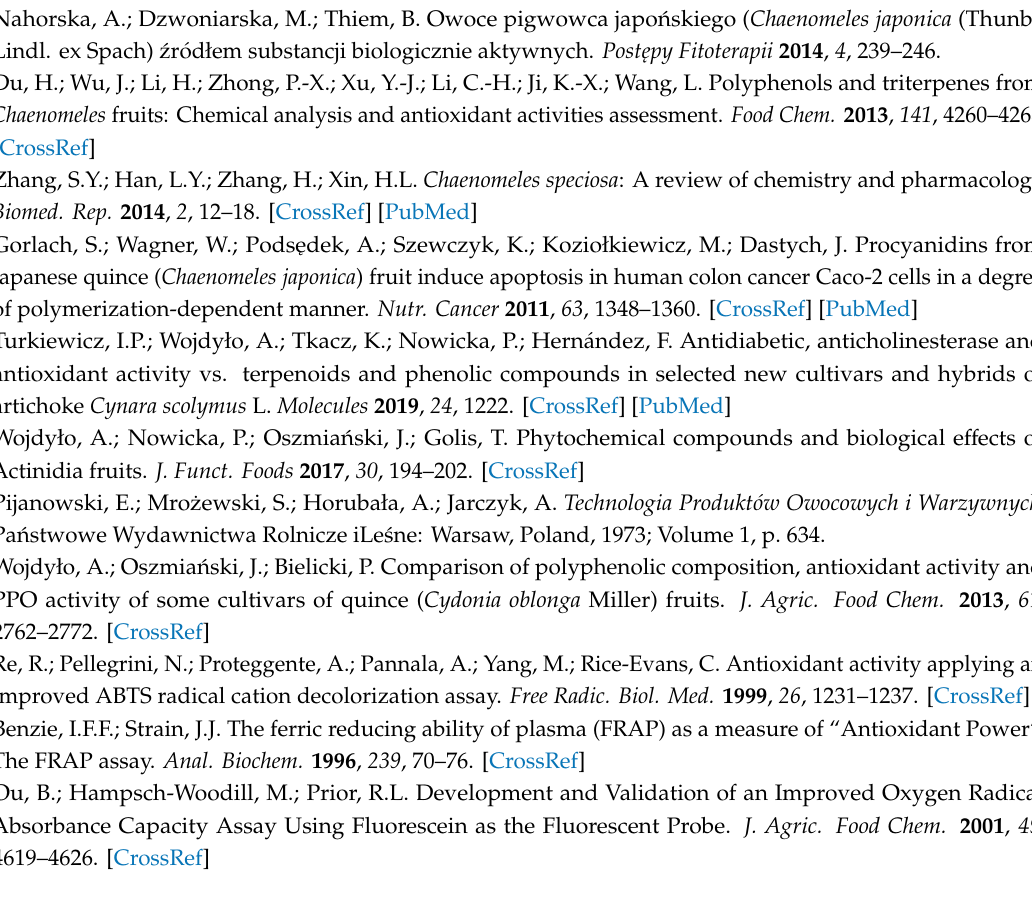
Figure S1: Structural formulas of selected phenolic compounds identified in Chaenomele s